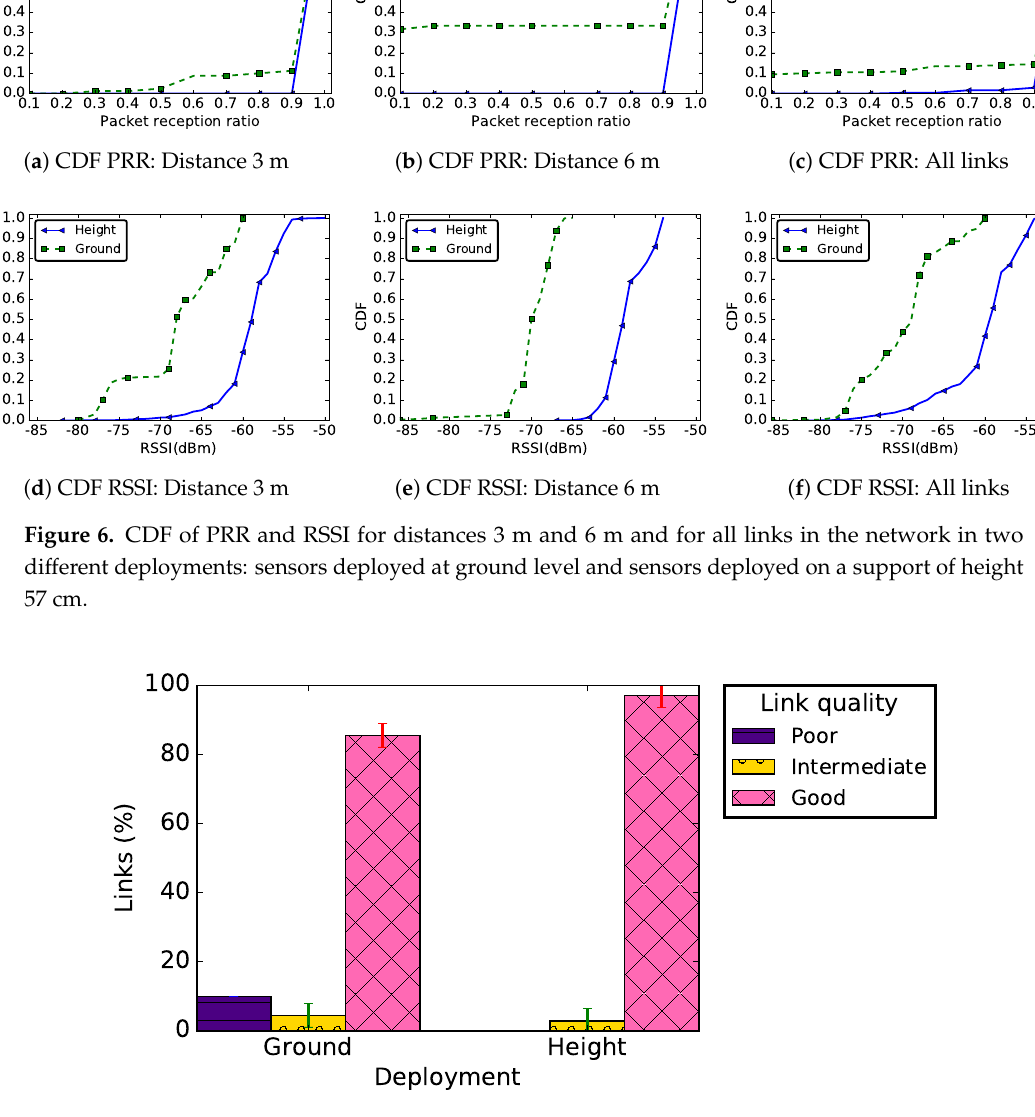
Figure 7. Link quality classification for a deployment at ground level and at